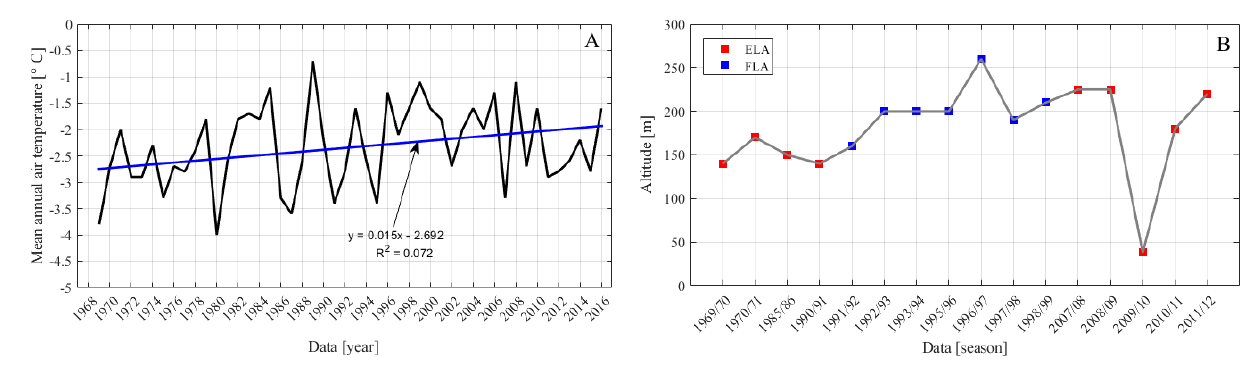
Figure 2. Mean annual air temperatures at Bellingshausen Station from 1969 – 2016 ( A ); and ELA changes on the Bellingshausen Dome ( B ).